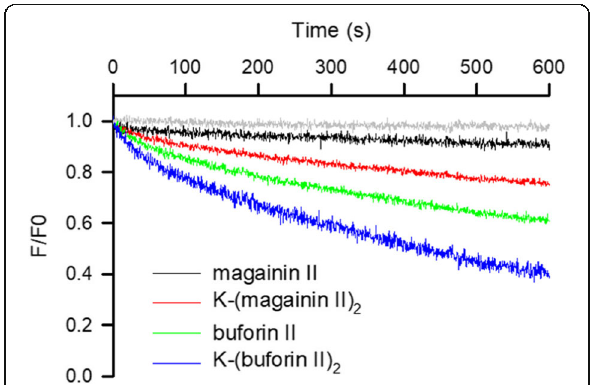
Fig. 3 Ability of peptides to translocate into liposomes. Membrane translocation of peptides was measured by resonance energy transfer from Trp to DNS-PE. Decreased fluorescence means that the peptide has entered the vesicle. Lipid and peptide concentrations were 100 and 1 μ M,